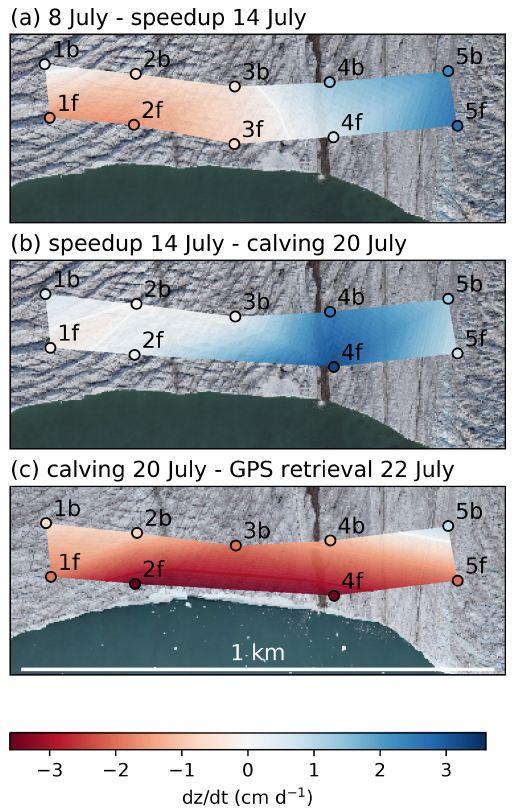
Figure 10. GPS-derived elevation change averaged over three time periods indicated above each panel (a – c) . The observations are interpolated linearly between the stations to visualize the spatial pattern of elevation change. The UAV-derived ortho-images in the background are from 15 July (a, b) and 21 July 2019 (c) .